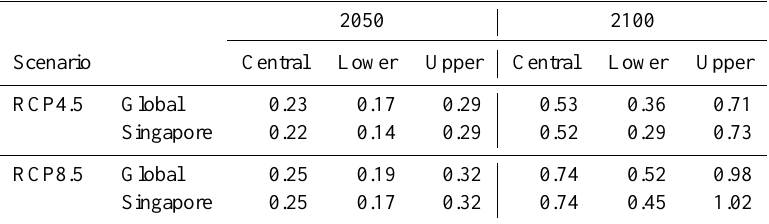
Table 3. Estimates of global sea level rise from the IPCC AR5 (Church et al., 2013) alongside our regional estimates for Singapore. Following the definitions in AR5, there is a 66–100% chance that future sea level rise will fall within the ranges quoted. Based on current understanding, only the collapse of marine-based sectors of the Antarctic ice sheet, if initiated, could cause global mean sea level to rise substantially above the likely range during the 21st century. This potential additional contribution cannot be precisely quantified but there is medium confidence that it would not exceed several tenths of a metre of sea level rise during the 21st century (Church et al,